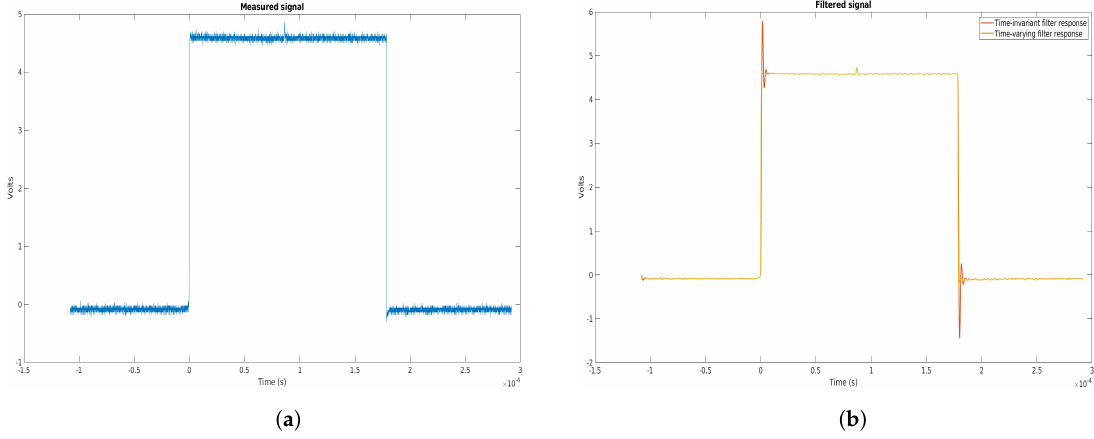
Figure 11. Measured ( a ) raw signal from the encoder and filtered signal ( b ) with LTI and LTV